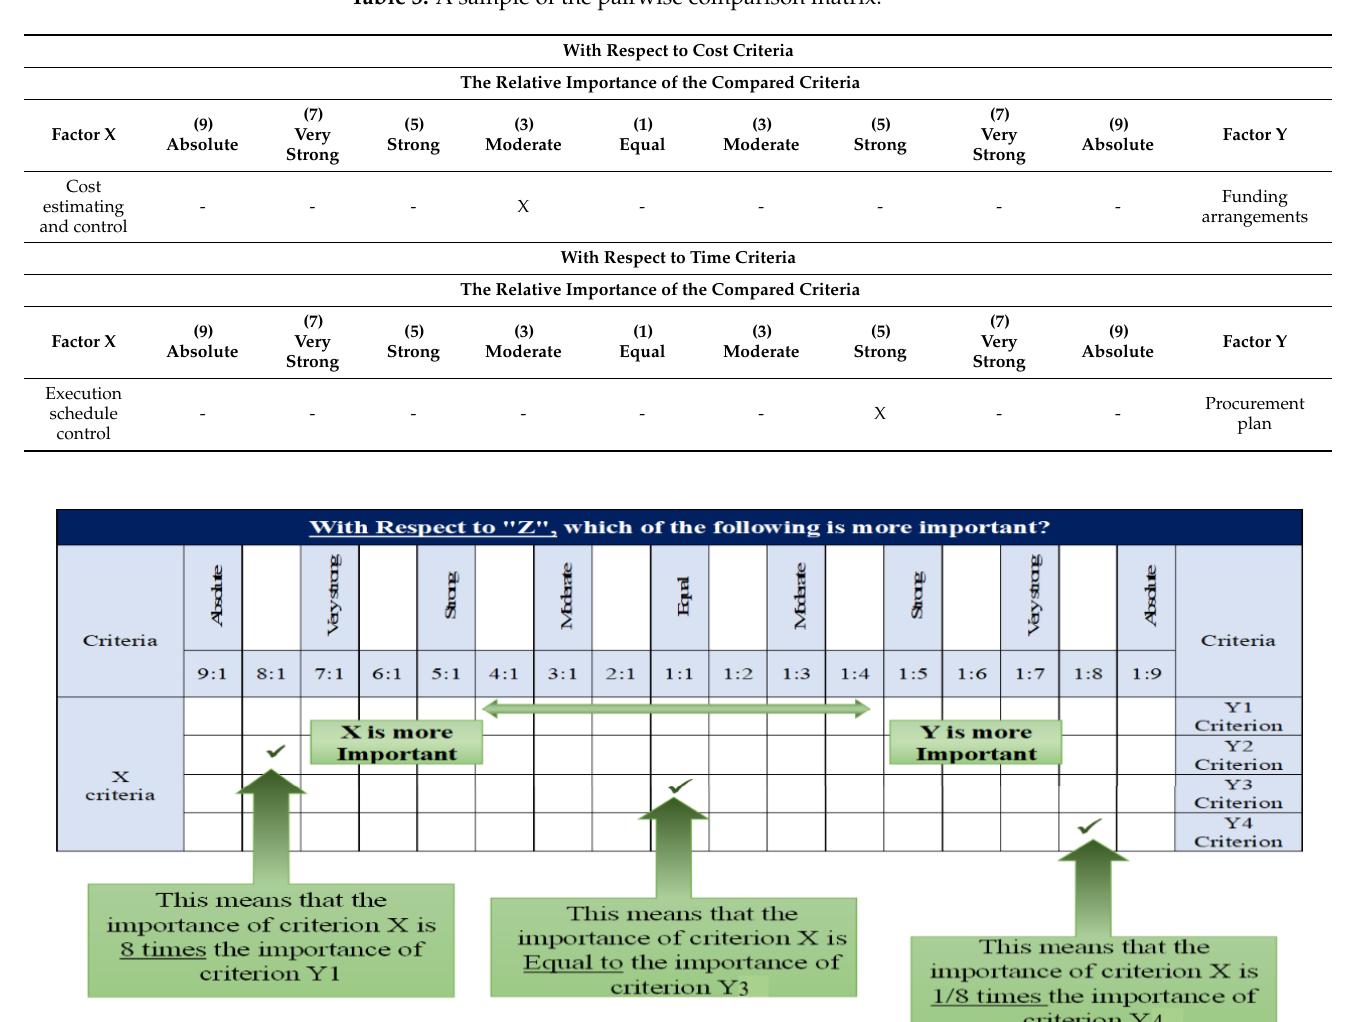
Table 3. A sample of the pairwise comparison matrix.